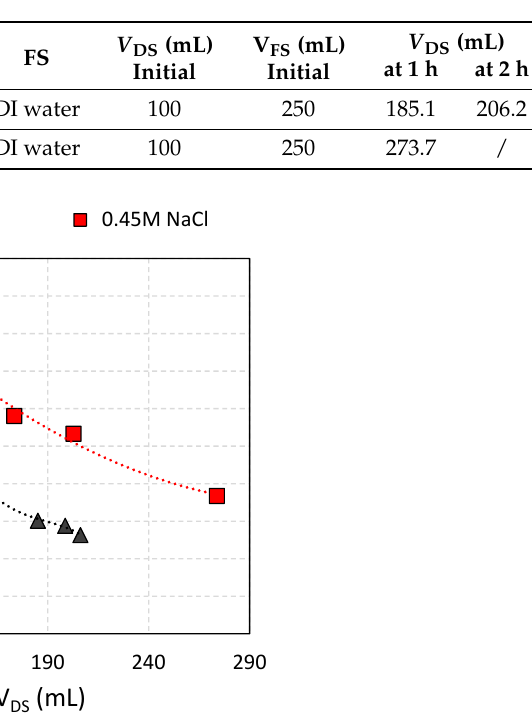
Figure 9. DS osmotic pressures with increased volume, for 0.45 M NaCl and Fe 3 O 4 @CA as DS and DI water as FS, respectively.